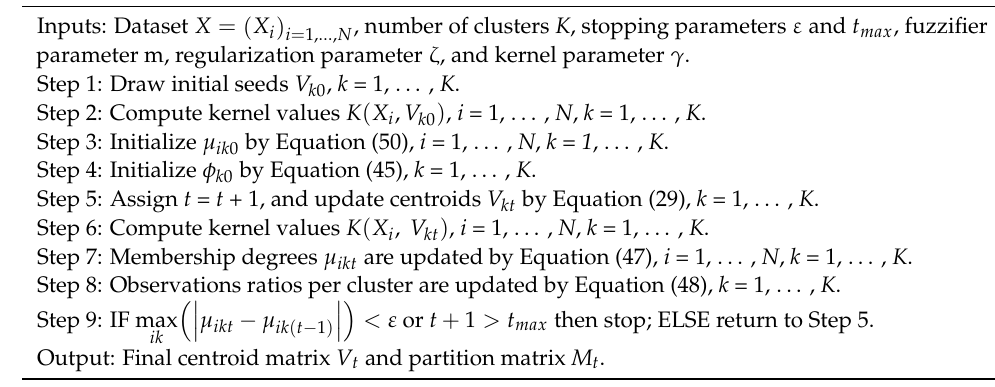
Algorithm 2. Fuzzy C-Means with R é nyi Divergence, Cluster Sizes and Gaussian Kernel